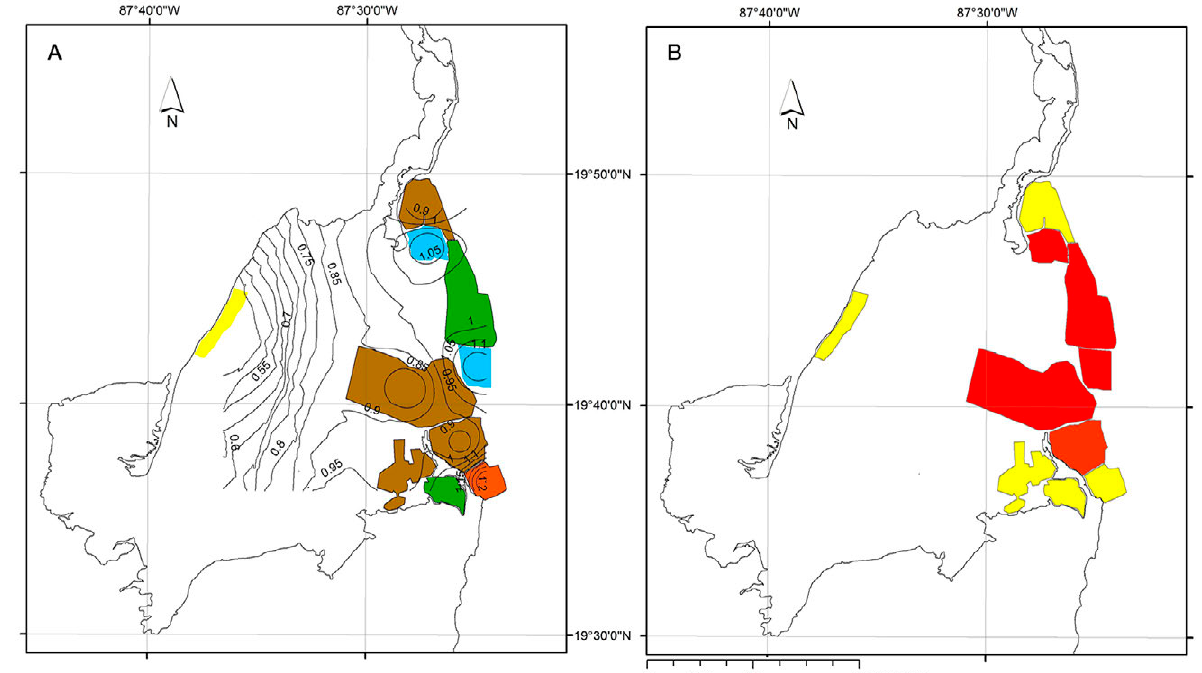
Fig. 5. – A, five homogenous groups of fishing areas (orange, blue, green, brown and yellow) and isolines for CPUE (kg shelter –1 ) harvested per trip identified using a Tukey HSD test; B, fishing areas with significant interactions between seasons (red) and without (yellow) of mean CPUE (kg shelter –1 ) harvested per trip identified using a Tukey HSD